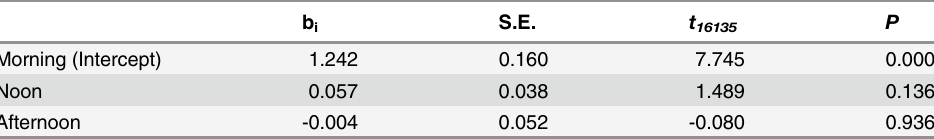
Table 2. Diurnal trend in visiting dynamics.